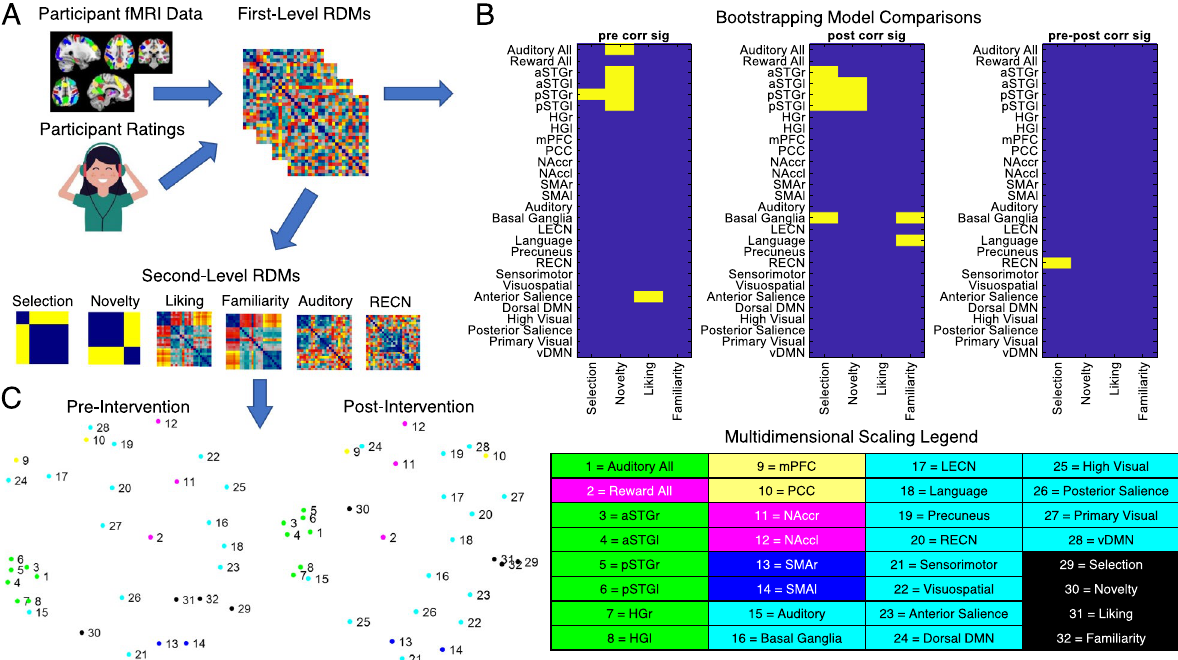
Figure 5. Representational similarity analysis. ( A ) Schematic of RSA processing pipeline. Participant-specific Ratings and task fMRI data are used to generate first-level representational dissimilarity matrices. First- Level RDMs are then used in 10,000-fold bootstrap resampling comparisons of models to functional RDMs for each participant. Resulting relatedness values are used in 50,000-fold t-max permutation testing ( B ) to determine significant (yellow) model-brain relationships at pre-intervention and post-intervention, as well as any significant effect of session (p < 0.05). First-Level RDMs are then averaged across participants to generate second-level RDMs, which are used to produce second order multidimensional scaling visualizations of RDM relatedness ( C